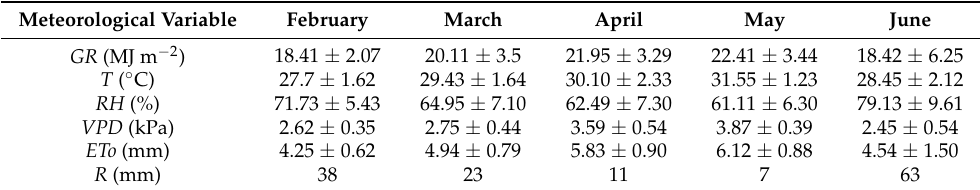
Table 2. Global radiation ( GR ), temperature ( T ), relative humidity ( RH ), vapor pressure deficit ( VPD ), potential evapotranspiration ( ETo ), and rain during the experimental work (February to June 2019). Meteorological